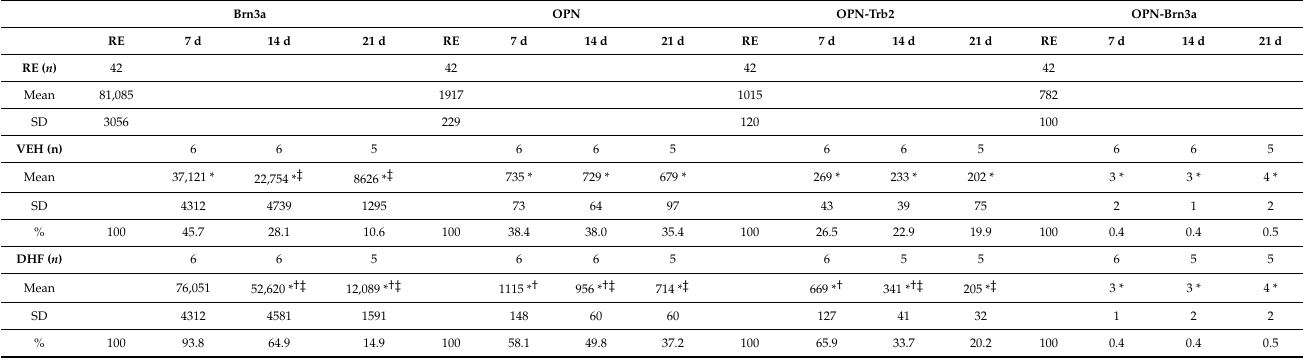
Table 1. Numbers of Brn3a + RGCs, OPN + RGCs, OPN + Trb2 + RGCs and OPN + Brn3a + RGCs (mean ± SD; Standard Deviation) in contralateral (RE) and experimental retinas analyzed 7, 14 and 21 days after intraorbital transection of the left optic nerve and daily i.p. treatment with vehicle or DHF (5 mg/kg) from one day before optic nerve injury until processing. One-way ANOVA * Significant when compared with contralateral retinas in the same RGC type ( p < 0.001). One-way ANOVA † Significant when compared with vehicle-treated retinas in the same RGC type at the same time point ( p < 0.05). One-way ANOVA ‡ Significant when compared with the previous time point in the same RGC type ( p < 0.05). RE, contralateral right retinas. 7 d, 14 d, 21 d, experimental left